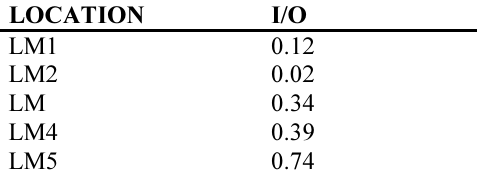
Fig. 4. Daily average outdoor NO 2 in Zirmunai monitoring station. The bars represent standard deviations Table 3. I/O ratio obtained in the different locations LOCATION